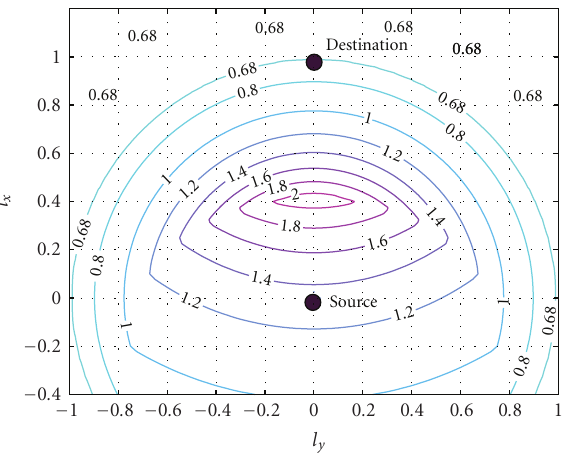
Figure 6: Ergodic capacity versus the location of the